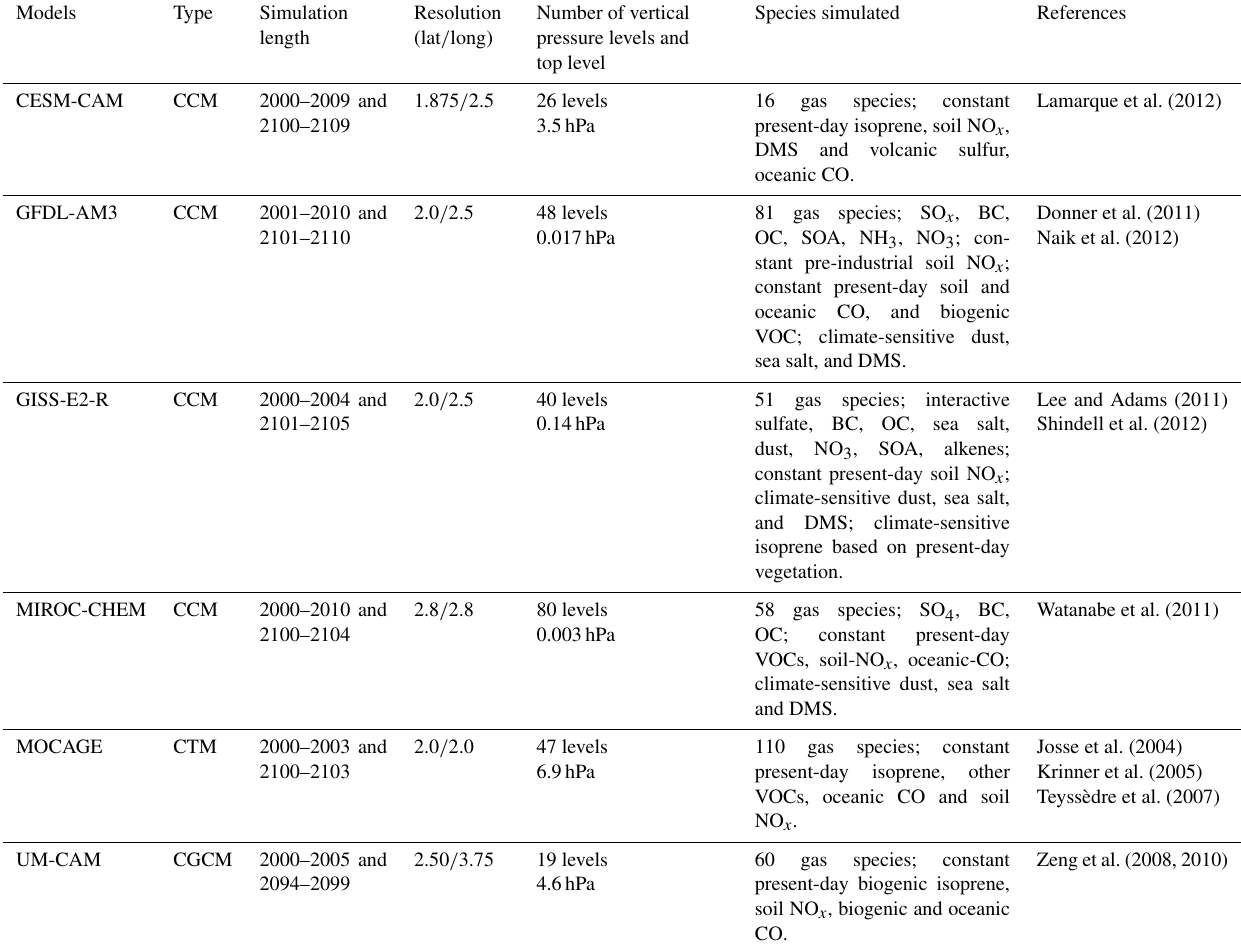
Table 1. Characteristics of the models, including simulation time slice, spatial resolution, simulated gas species and associated bibliographic references (from Lamarque et al., 2013 and Young et al., 2013). BC is black carbon, OC is organic carbon, SOA is secondary organic aerosols, DMS is dimethyl sulfide, CCM is chemistry climate model, CTM is chemistry transport model and CGCM is chemistry general circulation